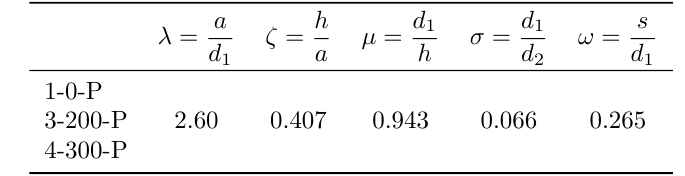
Table 3. Non-dimensional kinematic constants.